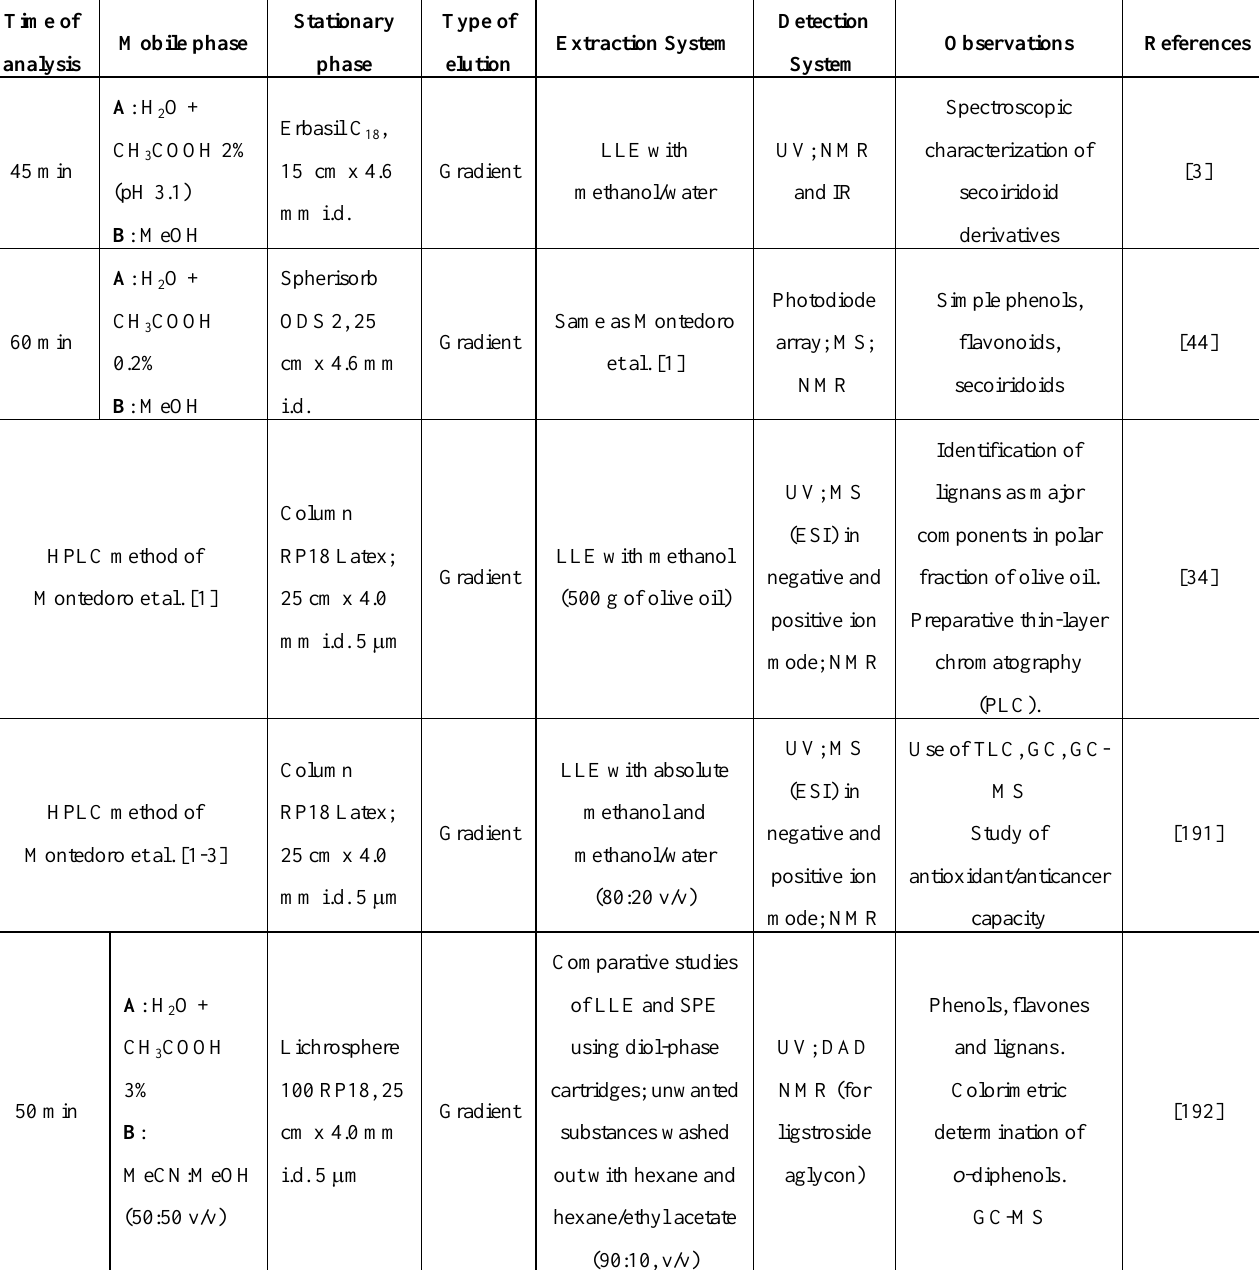
Table 3. Summary of separation of phenolic compounds in the polar fraction of